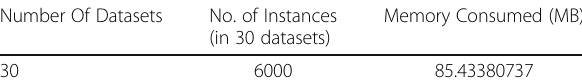
Table 2 Summary of discovery astroturfing groups